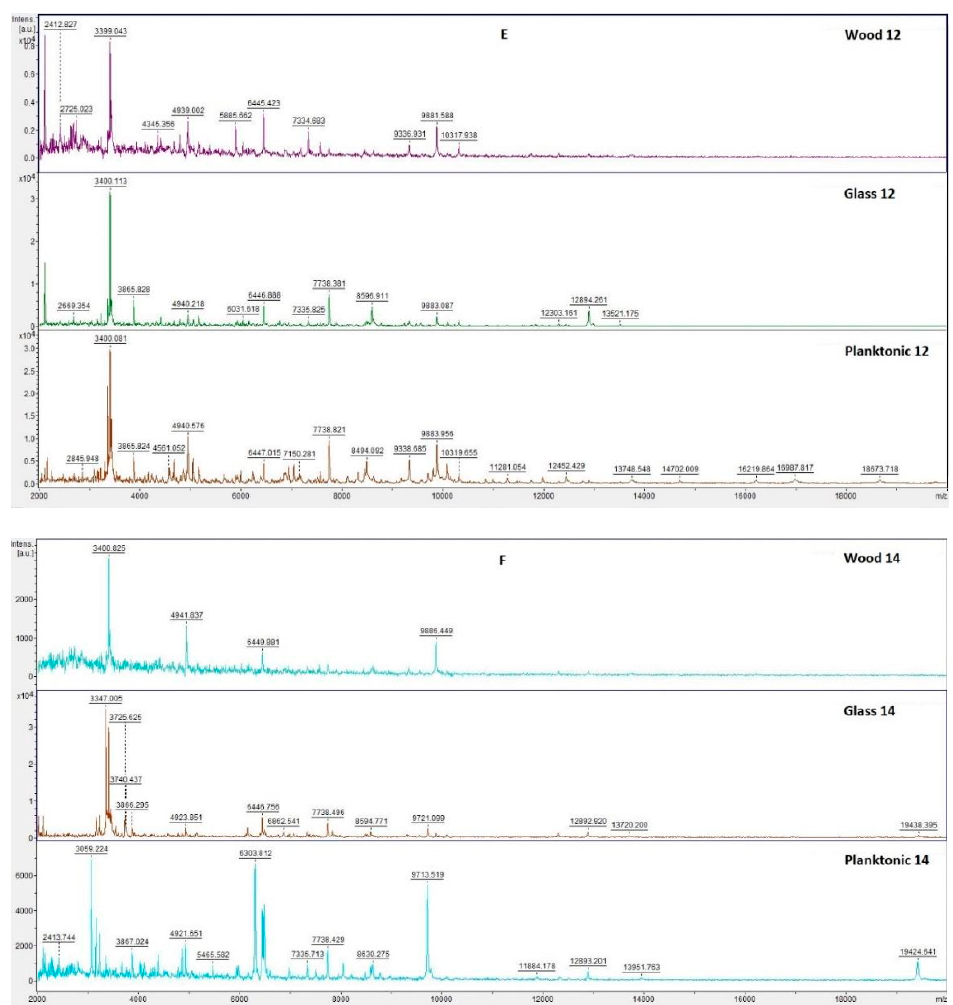
Figure 3. MALDI-TOF mass spectra of S. maltophilia during biofilm development: ( A ) 3rd day, ( B ) 5th day, ( C ) 7th day, ( D ) 9th day, ( E ) 12th day, and ( F ) 14th day.